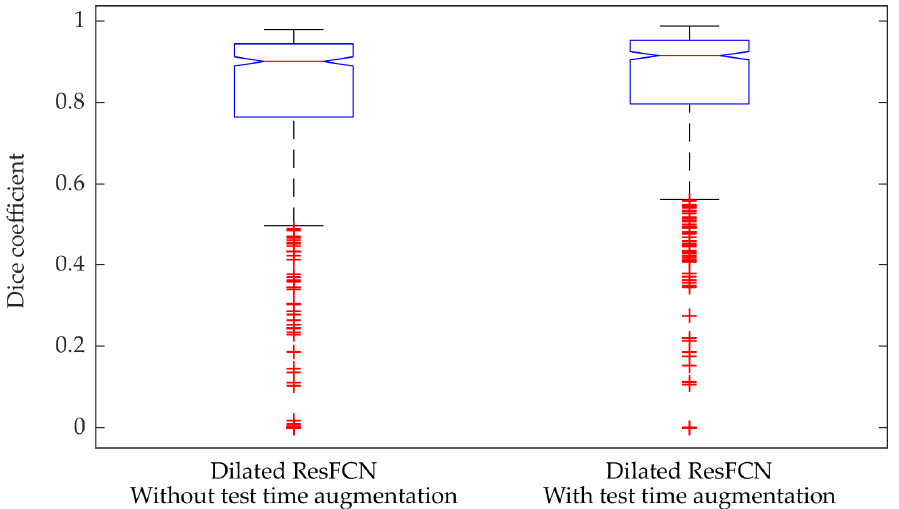
Figure 8. Box plot of the Dice coefficient obtained for the Dialted ResFCN without and with the test time augmentation.